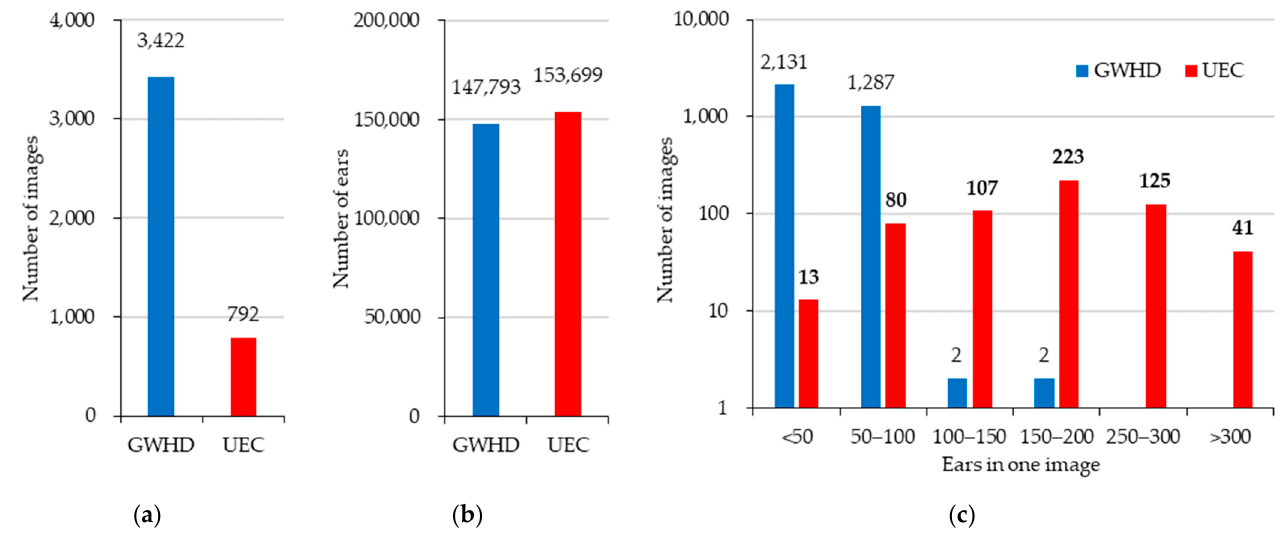
Figure 12. Comparison between GWHD dataset and UEC dataset. ( a ) Number of images. ( b ) Total number of labeled ears. ( c ) The number of ears in one image.